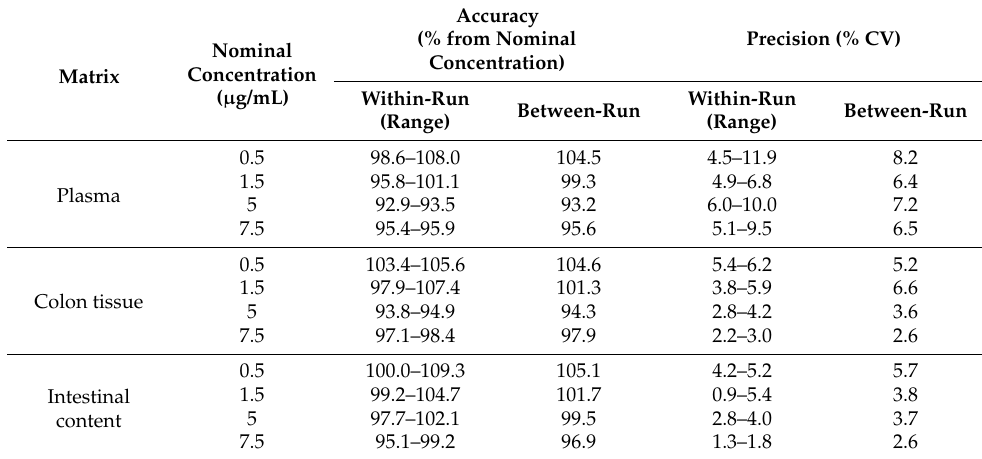
Table 2. Within-run and between-run accuracy and precision for the samples processed a